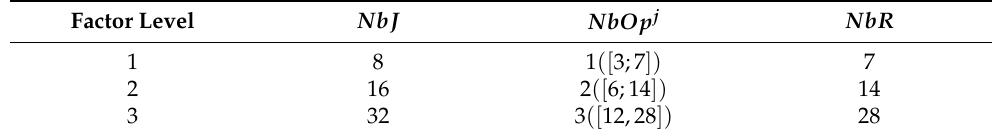
Table 4. Experimental design parameters for process scalability